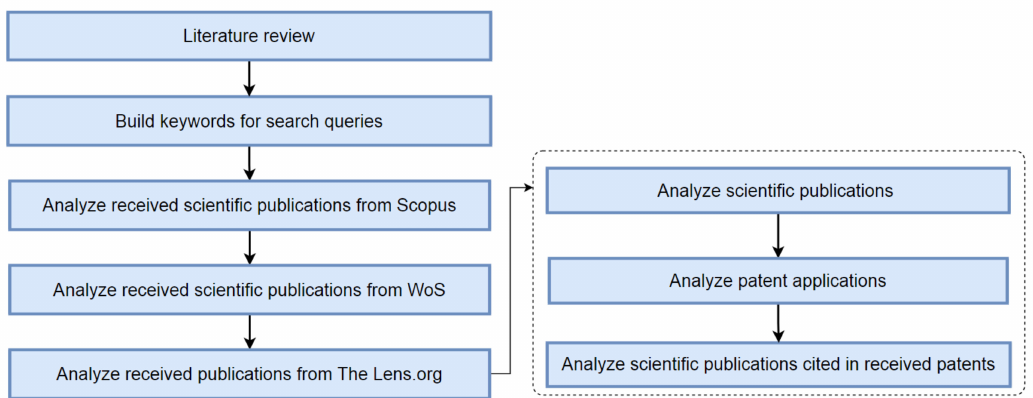
Figure 1. The overall procedure of the proposed